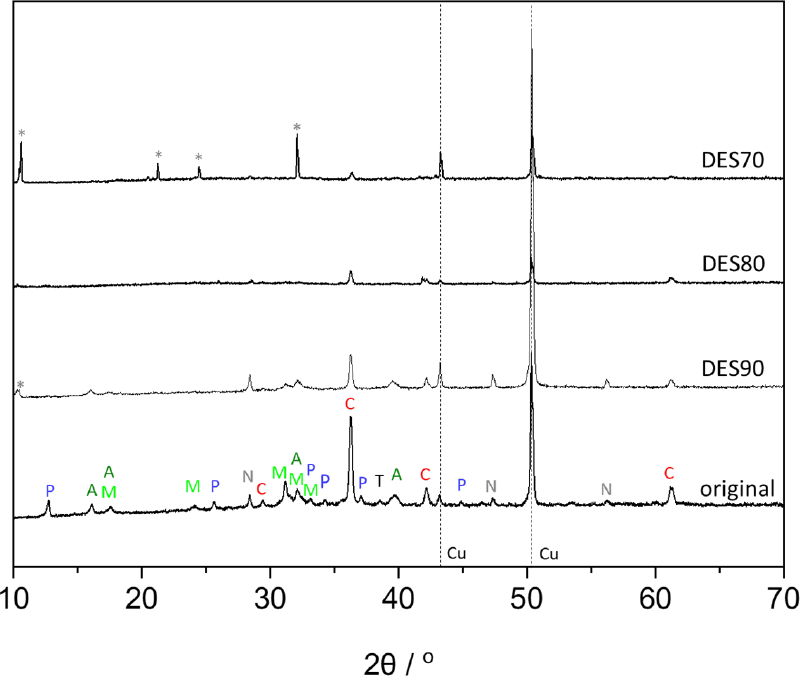
Figure 4. XRD spectra of electrochemically corroded copper sheets before and after corrosion removal using DES aq. absorbed in cellulose membranes. The letters in the spectra designate the peaks of tenorite (T), cuprite (C), atacamite (A), nantokite (N), and malachite (M), and posnjakite (P), while asterisks denote the unknown peaks.